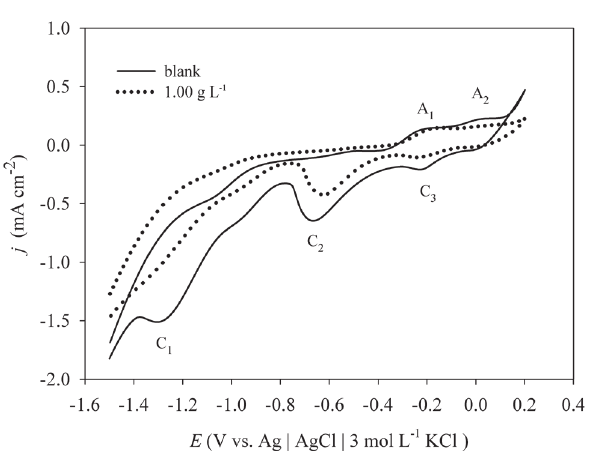
Fig. 2 – Cyclic voltammograms for the Cu electrode in simu­ lated acid rain solution, pH 4.5, in presence and absence of the HI extract (shown in figure); ν = 40 mV s −1